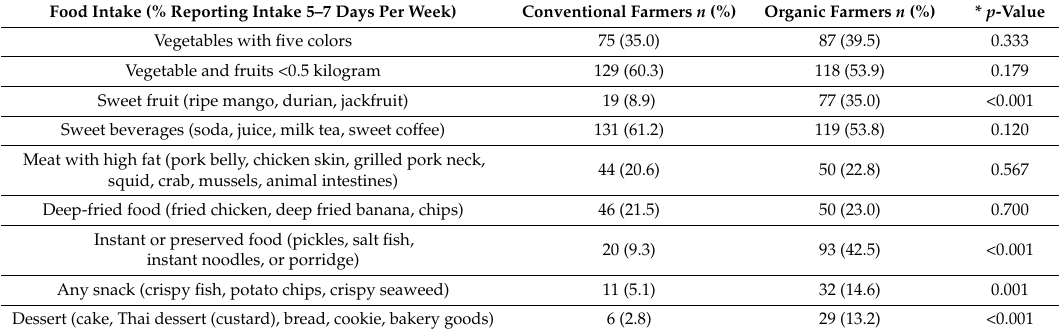
Table 4. Conventional ( n = 214) and organic farmers ( n = 222)’ diet for 5–7 days per week in the prior